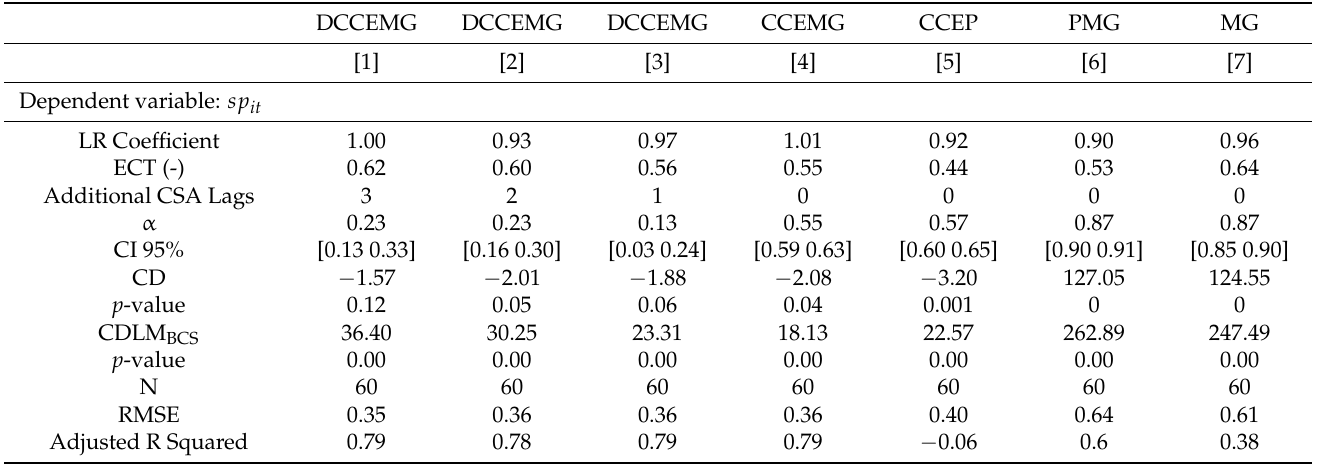
Table 8. Long-run panel